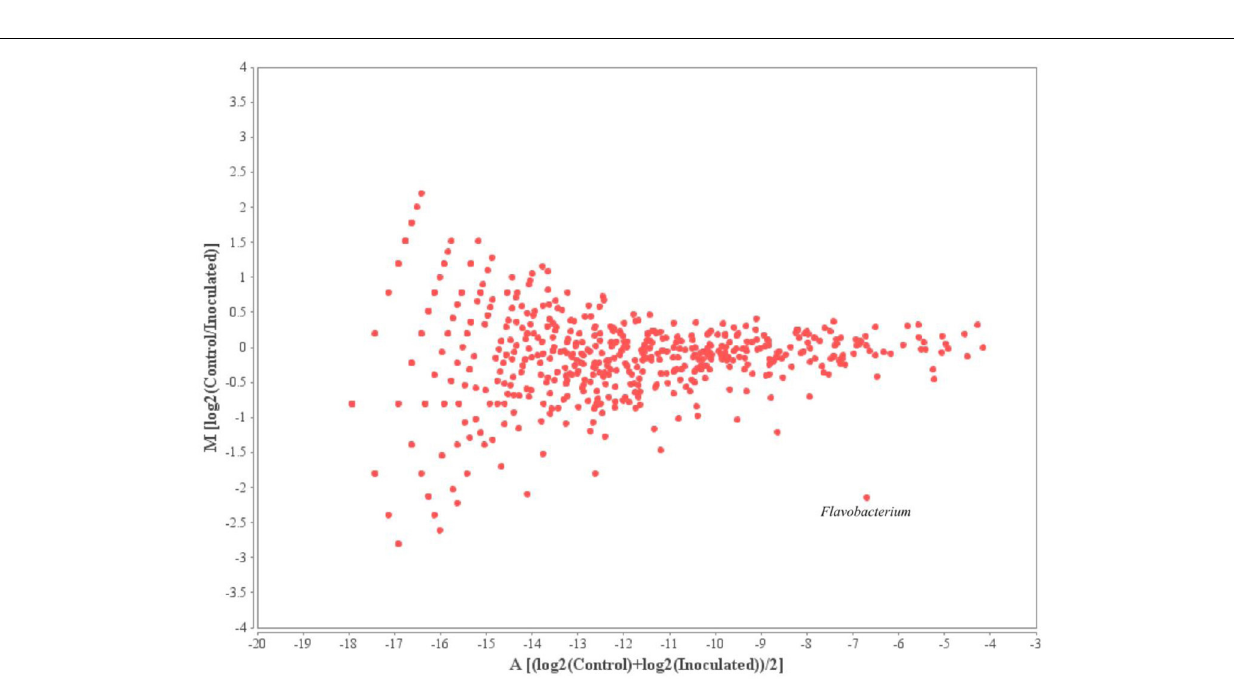
noticeable changes occurred in the subsystem of glutamine, glu- tamate, aspartate, asparagine and ammonia assimilation with frequencies increasing from around 10.3% to values around 11% in the samples taken after 2 and 5